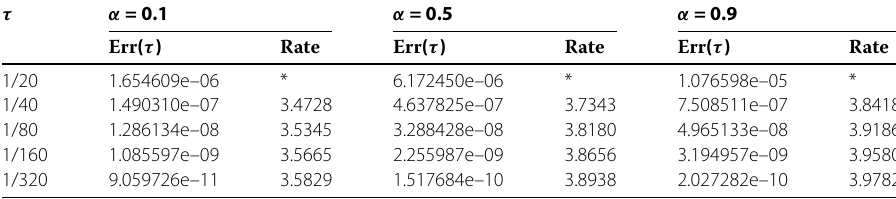
Table 4 Numerical errors and convergent orders with λ = 2, T = 1, when q =